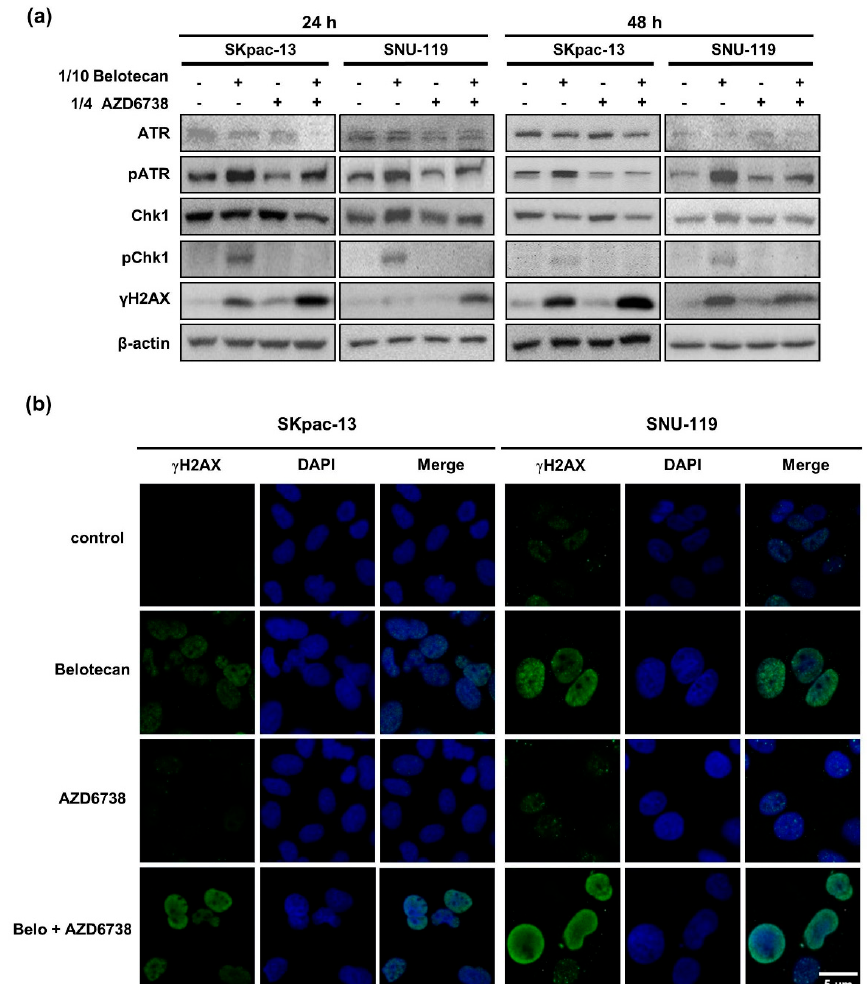
Figure 3. AZD6738 induces DNA double-strand break by suppressing the DNA damage response caused by belotecan. ( a ) Belotecan monotherapy-induced phospho-ATR (pATR) and phospho-Chk1 (pChk1) were suppressed again by the addition of AZD6738 to belotecan. The expression of the proteins was determined by a Western blot analysis and beta actin was used as a loading control. ( b ) Immunocytochemistry demonstrated that pan-nuclear γ H2AX was significantly increased by the combination of AZD6738 and belotecan. The images were taken at 40 × magnification and the scale bar was shown at 5 µ